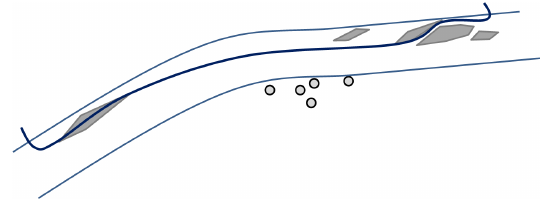
Figure 3. Overview over the study reach of the restored Chriesbach. The light blue lines delineate the Chriesbach, albeit without follow- ing the exact contour of the shoreline. The light grey structures rep- resent in-stream gravel islands; the circles represent piezometers. The dark blue line shows the approximate position of the fibre-optic cable.